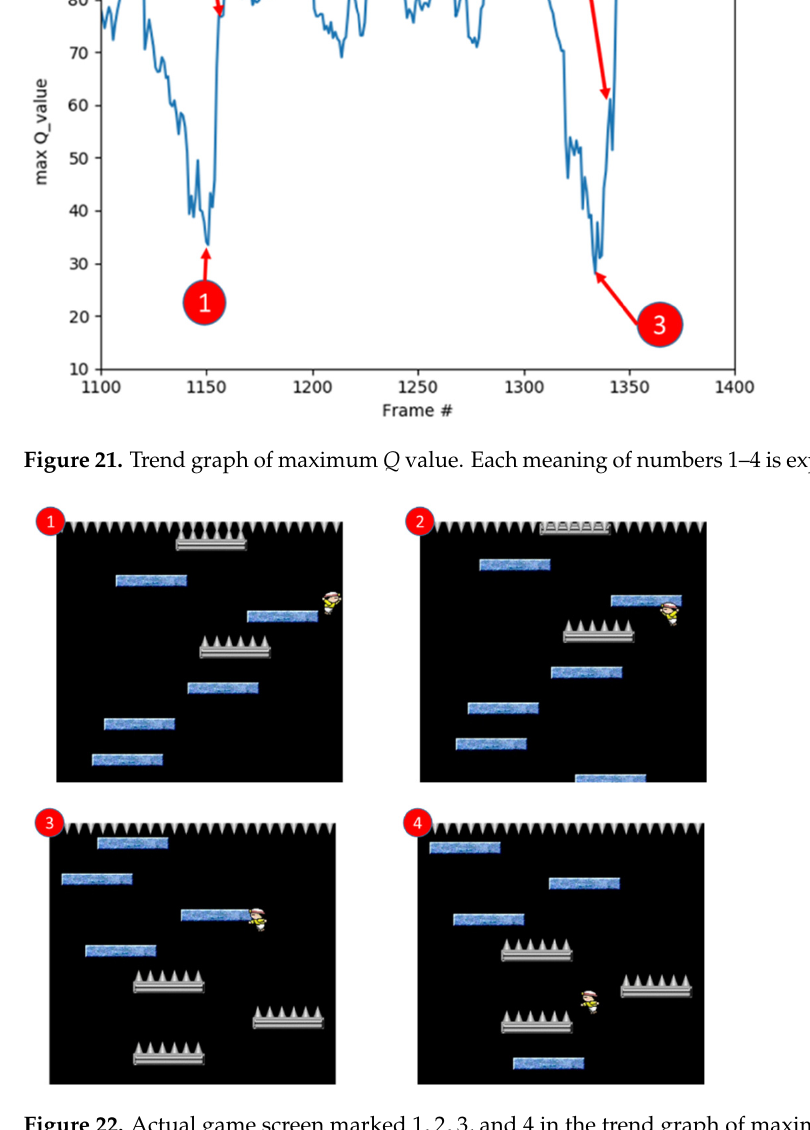
Table 17. The comparison with other methods by the average number of reached floors in the best 100 rounds of 2600